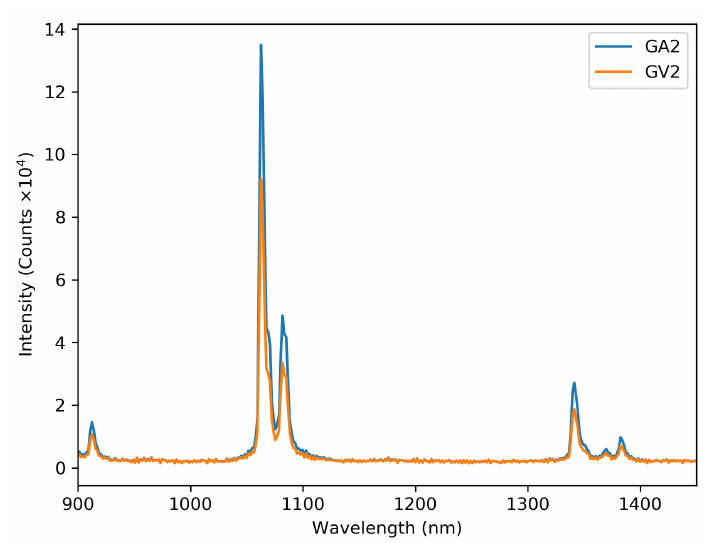
Figure 12. The recorded emission spectra of GA2 and GV2. Excitation with a 500 mW 808 nm laser.